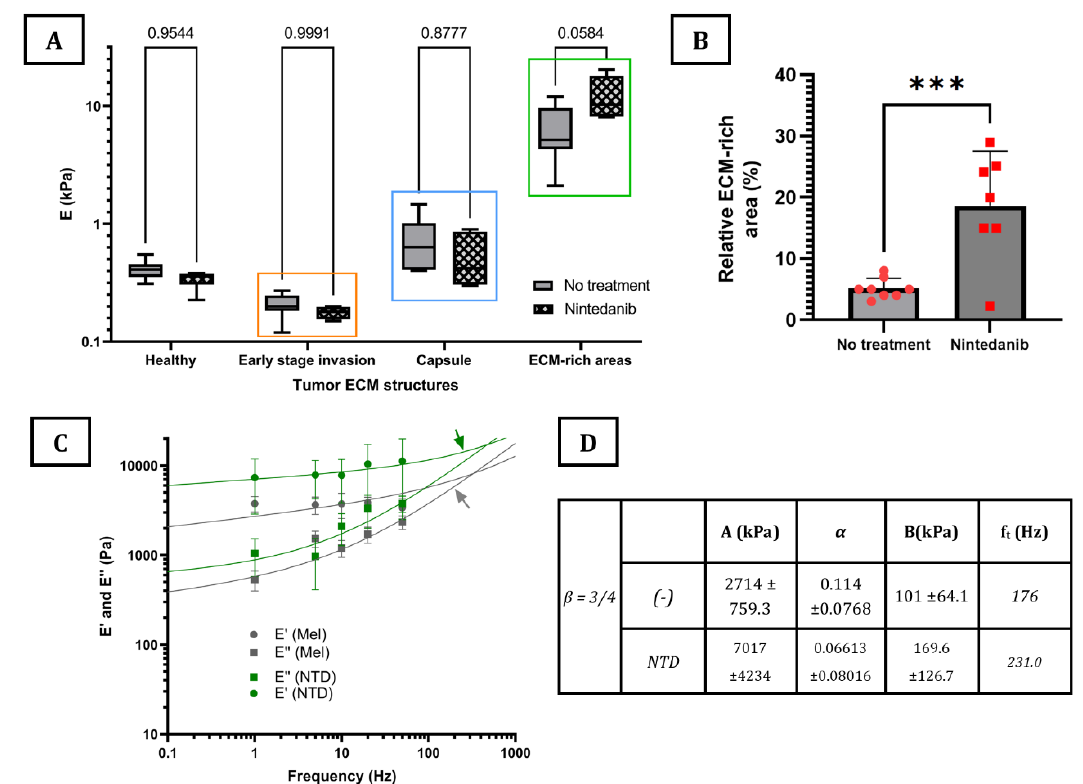
Figure 7. Nintedanib effects on structure and microscale mechanics of melanoma lung metastases. ( A ) Atomic force microscopy (AFM) measurements of the Young’s modulus (kPa) of each ECM structure of MEL metastases that either received no treatment or treatment with NTD. p -values were obtained using a two-way analysis of variance (ANOVA) with a Tukey post hoc multiple comparisons. ( B ) ECM deposition of ECM-rich regions of MEL macrometastases with and without NTD treatment. Measured by the tumor area occupied by the ECM-rich areas, where the total tumor area was normalized to 100%. Statistical analysis was performed using unpaired parametric student’s t -tests (***, p -value < 0.001). ( C ) Frequency dependent loss (E (cid:48) ) and storage (E (cid:48)(cid:48) ) modulus as measured by dynamic mechanical analysis (DMA) of the ECM of ECM-rich regions of MEL lung macrometastasis in NTD treated and non-treated mice. Solid lines represent the fits of the two-power law model. Arrows indicate the transition frequency. Fit parameters and transition frequency are detailed in table ( D